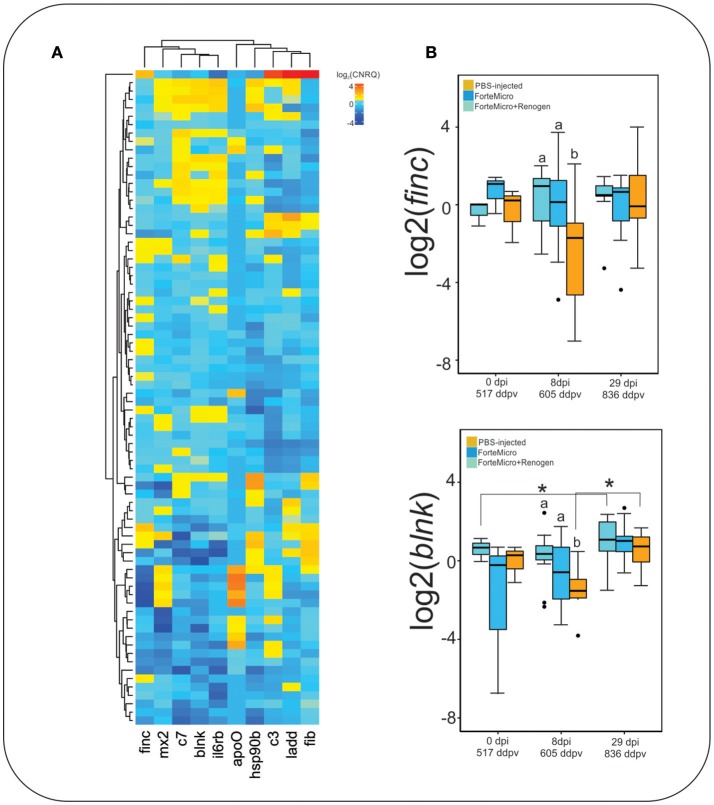
(A) Hierarchical clustering of expression profiles for all gene-sample combinations with qPCR. Values represent average log2-transformed relative quantities for all replicates of each treatment. (B) Expression profile of fibronectin and b-cell linker protein. Data represents the median log2CNRQ and 95% confidence intervals. Significant differences were detected with a two-way ANOVA followed by post-hoc Tukey HSD (p < 0.05). Differences within each time are denoted by lower-cased letters, while differences over time within groups are denoted by asterisk (*).